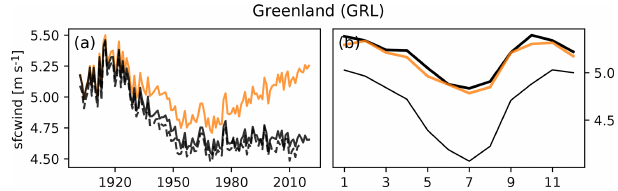
Figure 9. Same as Fig. 7 but for wind speed over Greenland (GRL).